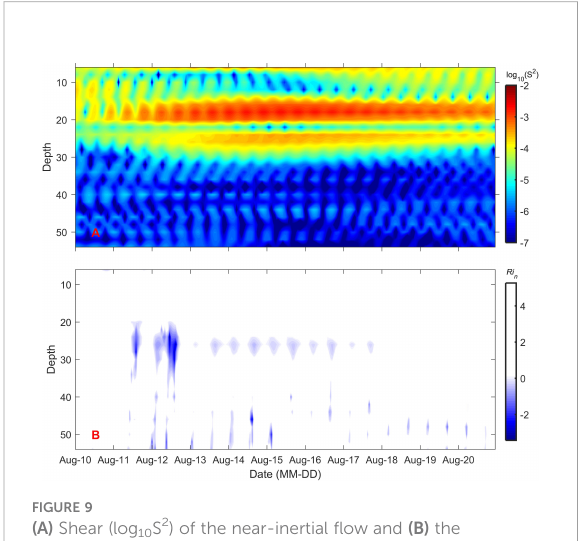
normalised Richardson number at the mooring